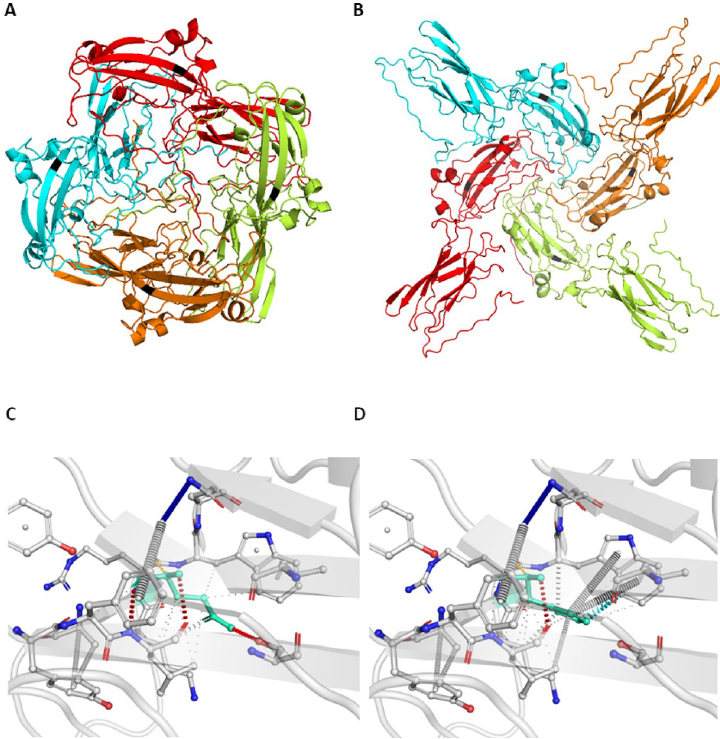
Fig 8. Tertiary and quaternary structural predictions of ORF3a protein. A. Structural prediction with REF-Q57H. B. Structural prediction with ALT-Q57H. The location of the 57th amino acid in both structures is denoted in grey. C. Detailed molecular structural conformational changes of ORF3a protein showing the REF-Q57H. D. Same molecular analysis for the structure with ALT-Q57H. Hydrogen bonds in red, weak hydrogen bonds in orange, halogen bonds in blue, ionic interactions in yellow, aromatic contacts in light-blue, hydrophobic contacts in green, carbonyl interactions in pink, VdW interactions in grey.